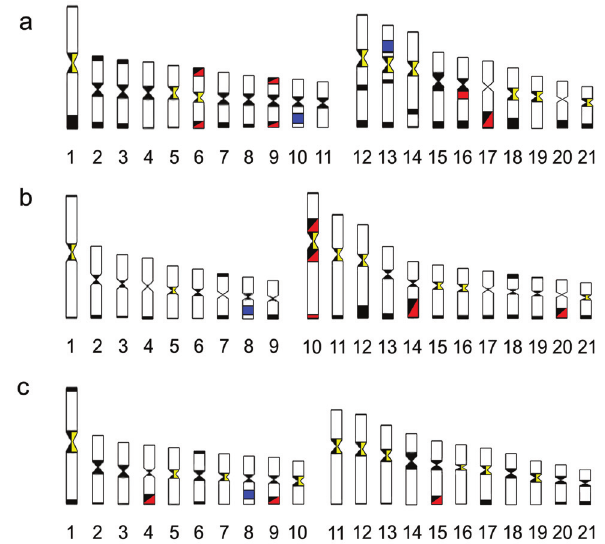
Fig. 3. Ideograms referring to the Hoplias malabaricus populations (karyomorph A) from the São Francisco ( a ), Araguaia ( b ) and Xingu ( c ) Rivers, highlighting the chromosome markers. Black = C-positive heterochromatin; blue = 5S rDNA sites; red = 18S rDNA sites; yellow = 5SHindIII satellite DNA